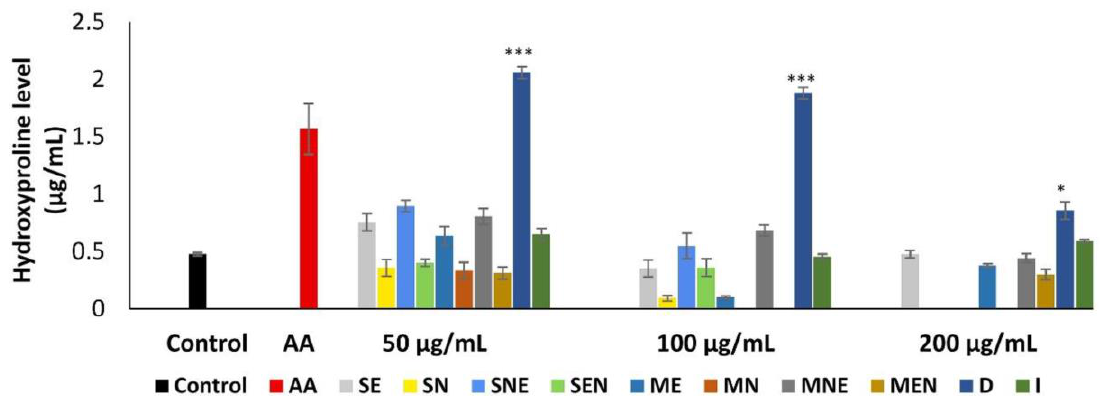
Figure 5. Effects of TS extracts on hydroxyproline content. Untreated fibroblasts were used as control. Ascorbic acid (AA) (25 µg/mL) was used as positive control. Data were presented as mean ± SEM (n = 3) and compared with the control group, * p < 0.05, *** p < 0.001. SE—Soxhlet ethanol, SN—Soxhlet